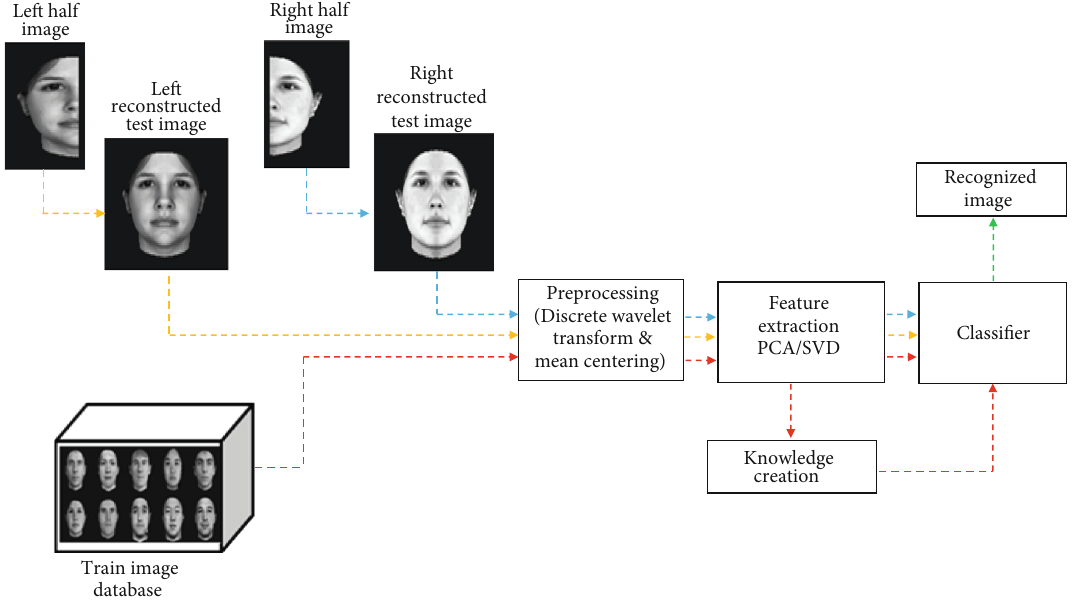
Figure 4: Research